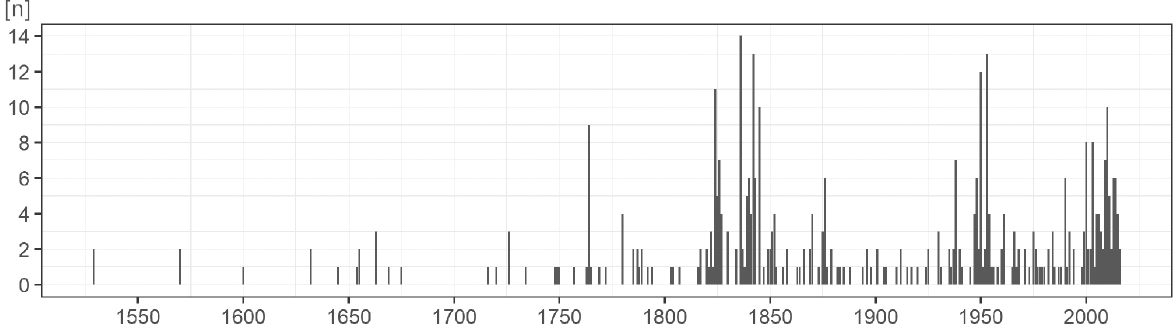
Fig. 3. Map and other sources dating frequency (note: figure include the FC).